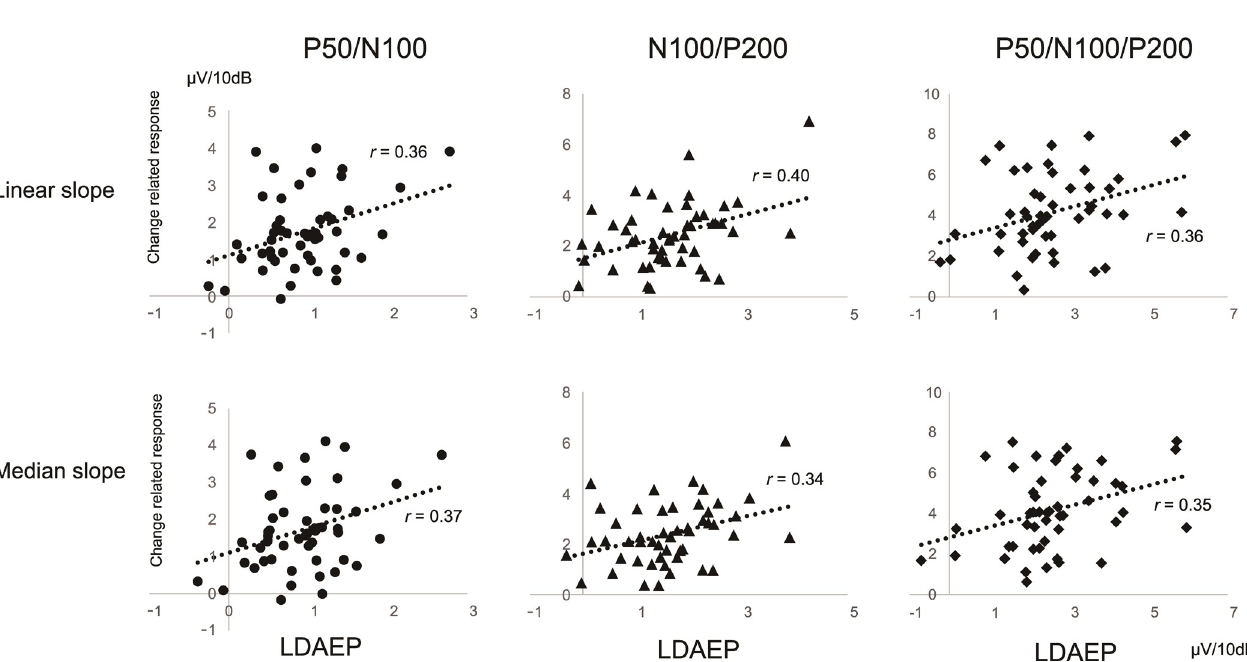
Fig 4. Correlation of the amplitude slope between LDAEP and the change-related response. Correlations between LDAEP and the change-related response in P50/N100, N100/P200, and P50/N100/P200 are shown in the linear slope and median slope.